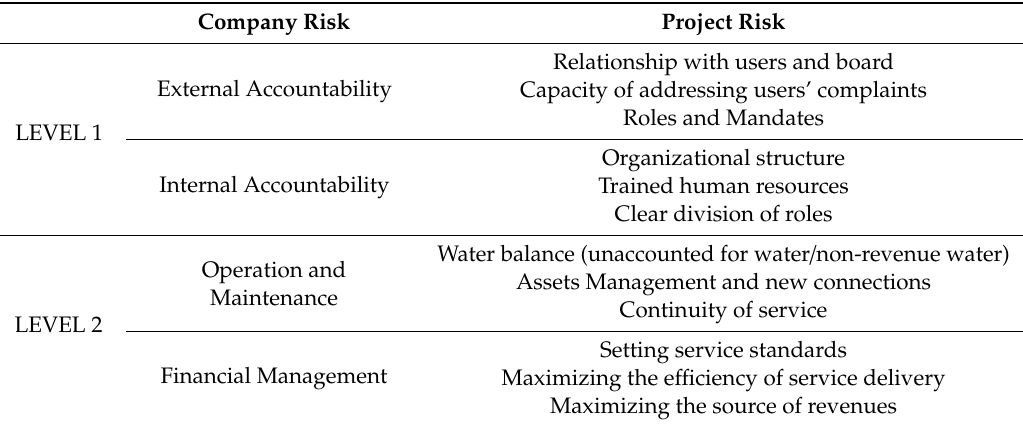
Table 2. Risk hierarchy model at company and project